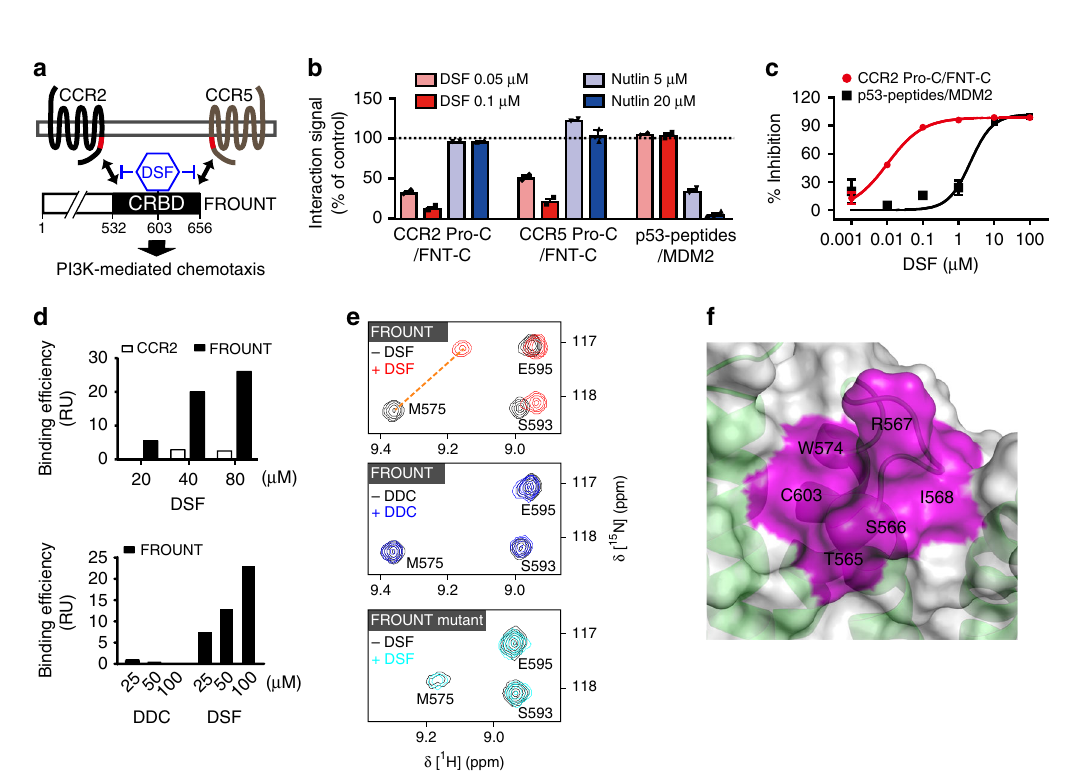
Fig. 5 Disul fi ram (DSF) binds FROUNT and inhibits its interaction with chemokine receptors. a DSF targets the interaction of CRBD (the chemokine receptor-binding domain) of FOUNT with CCR2 and CCR5 via a conserved binding region (shown in red). b , c HTRF interaction with DSF and the p53-MDM2 inhibitor, Nutlin ( b ) and titration assay ( c ). d Surface plasmon resonance assessment for DSF-binding signals to FROUNT versus CCR2 (upper panel) and FROUNT-binding signals of DSF versus its fi rst metabolite diethyldithiocarbamate (DDC) (lower panel). e NMR titration analyses of the binding of DSF and DDC to FROUNT. Representative NMR peaks derived from FROUNT or its mutant (C603S) in 1 H – 15 N HSQC spectra are shown. (Upper panel) The peaks before and after the 50 μ M DSF titration to 50 μ M FROUNT are shown in black and red, respectively. The largely perturbed M575 peaks ( Δδ > 0.17 ppm) are connected by an orange dashed line. (Middle panel) The peaks before and after the 50 μ M DDC titration to 50 μ M FROUNT are shown in black and blue, respectively. (Lower panel) The peaks before and after the 50 μ M DSF titration to 50 μ M FROUNT mutant are shown in black and cyan, respectively. f Enlarged view of the putative DSF-binding site of FROUNT. Cartoon model of CRBD with a transparent surface and a map of the largely perturbed surface residues ( Δδ > 0.17 ppm), labeled with their assignments and colored magenta. The other largely perturbed residues are buried inside the FROUNT structure. HTRF data in ( b ) and ( c ) show mean ± s.e.m.; duplicates from one of three independent